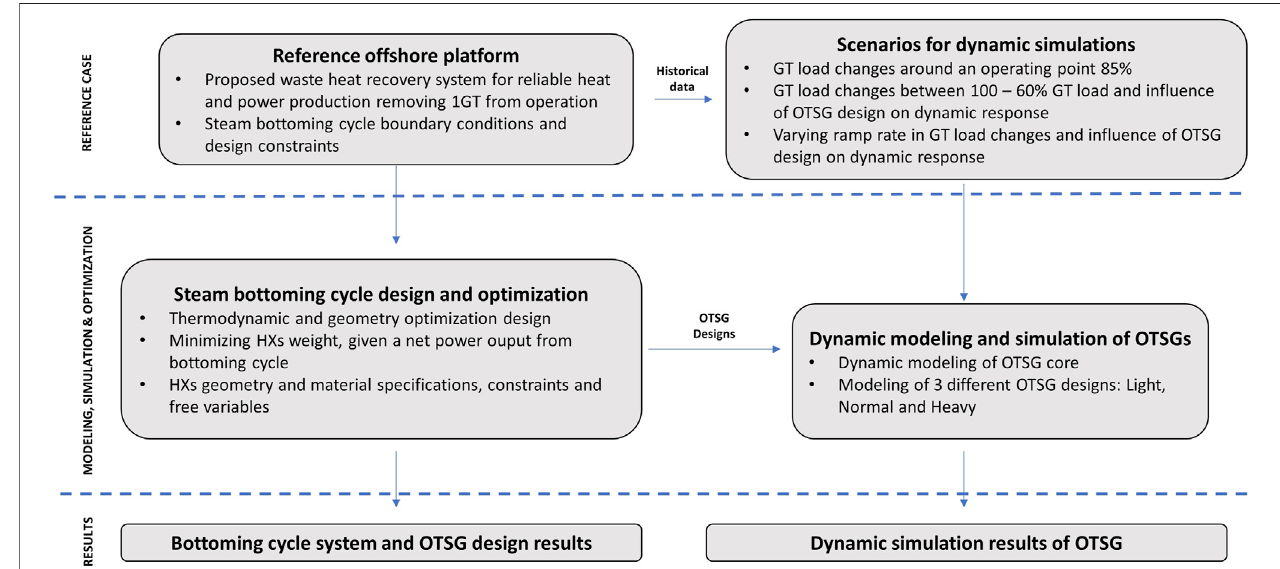
FIGURE1 | Method overview of reference off-shoreplatform, steam bottoming cycle design optimization, dynamic modeling of OTSG, and selection ofscenarios.